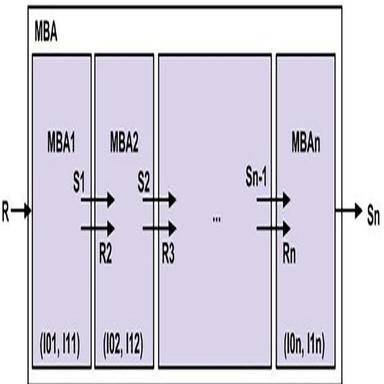
Accumulated sequential IDs are compared with the alarm threshold of 2.4 kg every campaign. If the accumulated data is above the threshold, an alarm is raised, and the operation stops. The current model does not involve material transfer after the alarm rise, but it stops the facility operation. MBAs storing inventories are excluded for this calculation, and only mid-processes are accounted for.